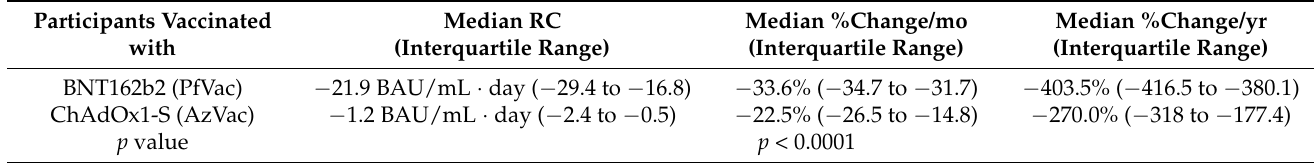
Table 2. Rate of change (RC) and percentage change per month (%change/mo) and percentage change per year (%change/yr) of anti-S1RBD IgG antibodies between 3 weeks after the second dose and 3 months after the second dose in participants vaccinated with BNT162b2 and ChAdOx1-S.